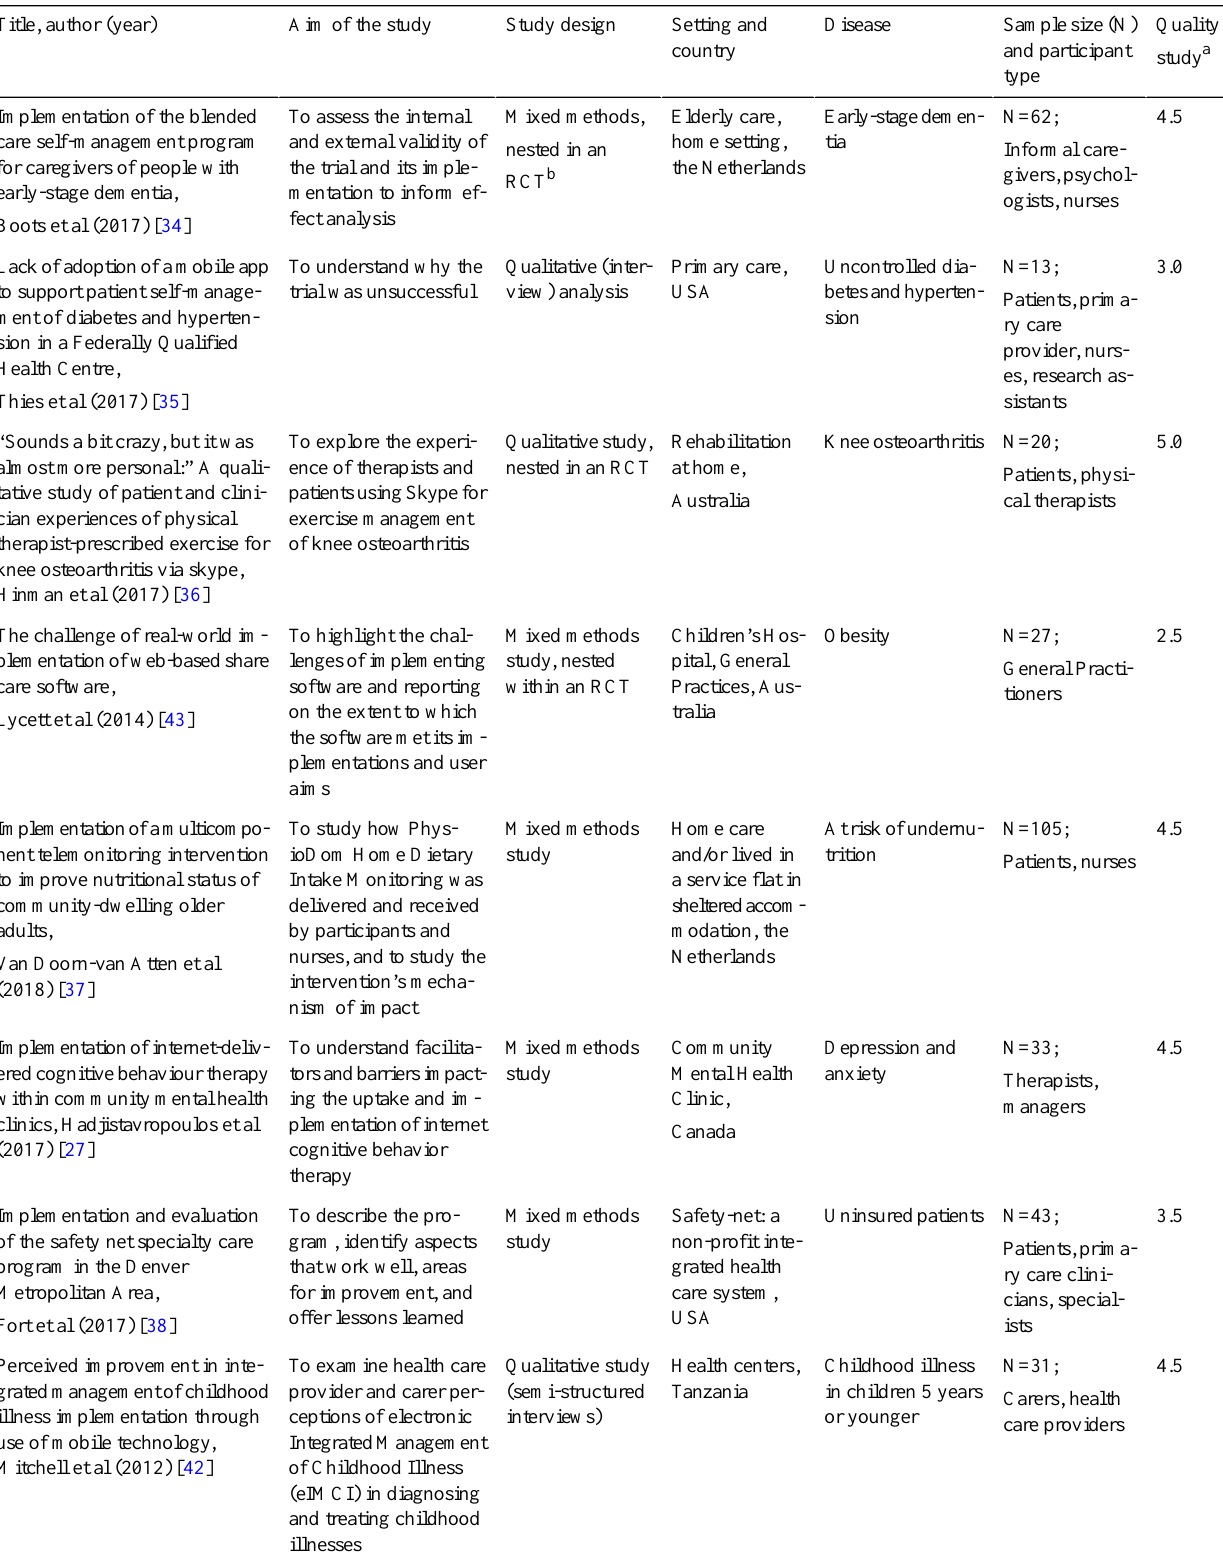
Table 2. Study characteristics.